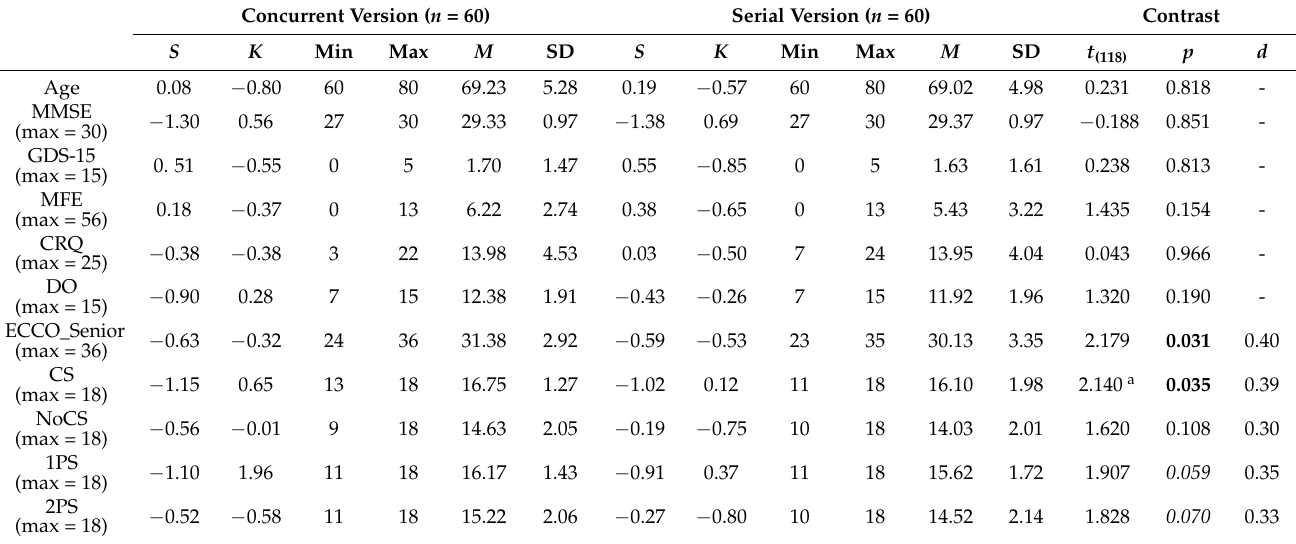
Table 1. Descriptive statistics and mean differences between groups for all